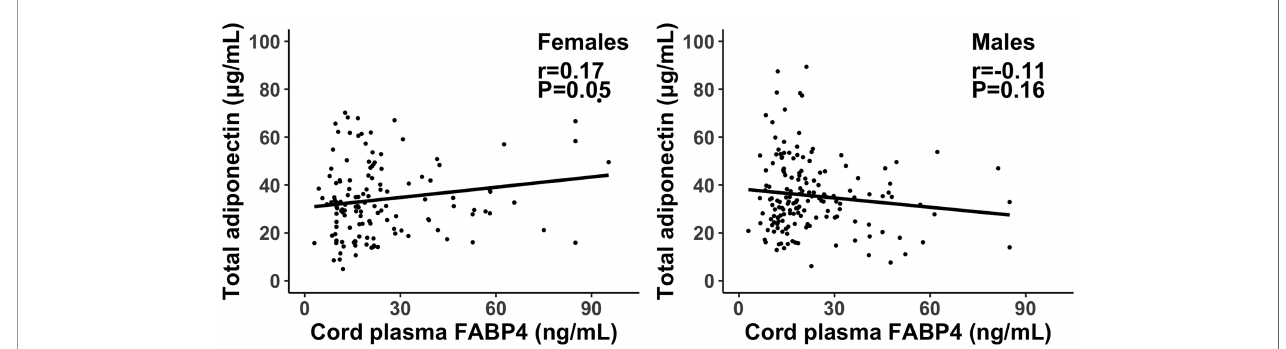
FIGURE 1 | Scatter plots illustrating the different correlations of cord plasma FABP4 with total adiponectin in female and male newborns; the interpolation represents the regression line. P=0.02 in Fisher ’ s z test for difference in the correlation coef fi cients in males and females.